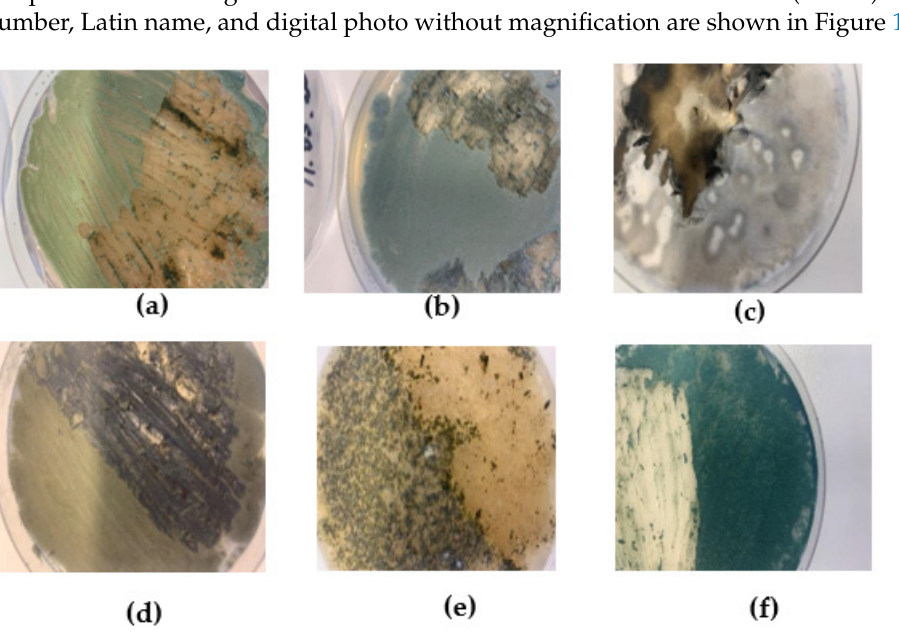
Figure 1. MSCL No., Latin name, and image of the fungi used in the experiment: ( a ) MSCL 1346 As- pergillus versicolor ; ( b ) MSCL 281 Penicillium chrysogenum ; ( c ) MSCL 280 Alternaria alternata ; ( d ) MSCL 258 Cladosporium herbarum ; ( e ) MSCL 851 Chaetomium sp.; ( f ) MSCL 309 Trichoderma asperellum